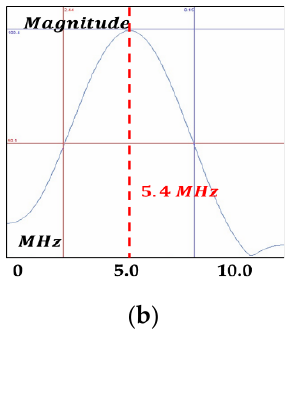
( d ) Figure 11. Results of 16th channel frequency analysis: ( a ) echo pattern of P/E type FPAPr; ( b ) fast Fourier transform (FFT) analysis results of P/E type FPAPr; ( c ) echo pattern of T/R type FPAPr; ( d ) FFT analysis results of T/R type FPAPr. The center frequencies measured in all channels were plotted on a graph in Figure 12. The results show similar center frequencies for all channels. The P/E type average center frequency was about 5.4 MHz, and the T/R type average center frequency was about 4.6 MHz. This satisfies the ISO 18563-2 standard of permission of ±10%. The difference between the average center frequency and each element frequency was a maximum of 6.5% and minimum − 7.0%, which satisfies the ±10% standard of permission of the same standard.